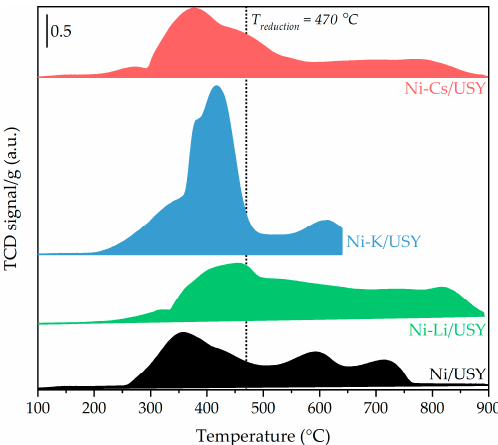
Figure 3. H 2 -TPR profiles obtained for Ni-A/USY catalysts. Note that for Ni-K/USY, the experiment was carried till 650 °C to prevent the eventual reaction of K compounds with the quartz reactor. was carried till 650 ◦ C to prevent the eventual reaction of K compounds with the quartz